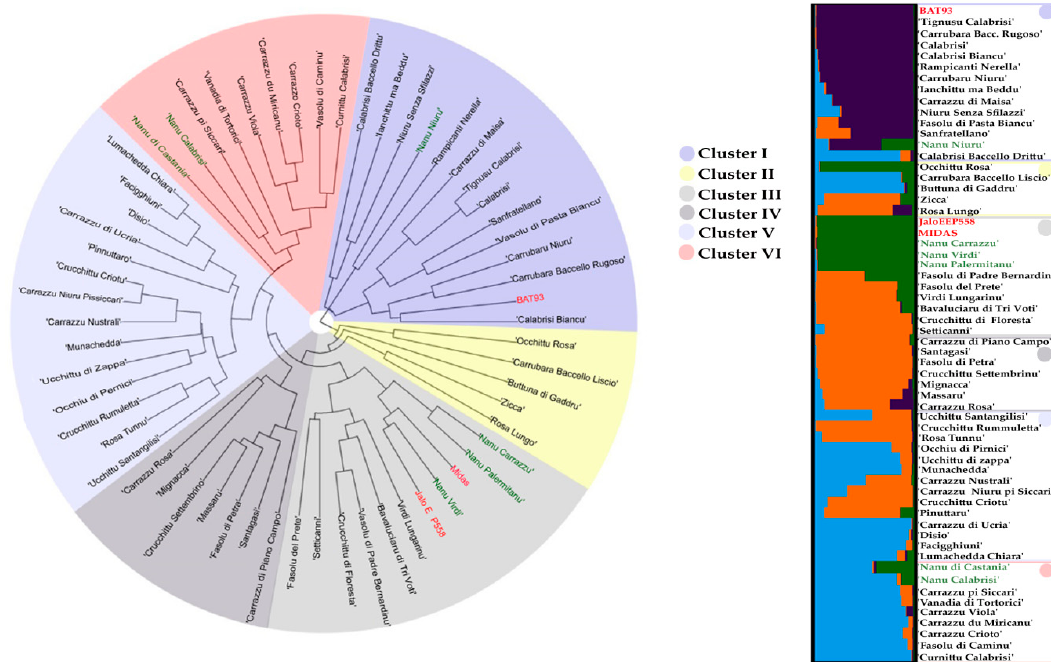
Figure 6. On the left phylogenetic analysis of Sicilian common bean germplasm collection, based on Bruvo’S distance coefficient and UPGMA cluster analysis. JaloEEP558, Midas (Andean) and BAT93 (Mesoamerican) were added as references. On the right Structure inferred for common bean germplasm collection analyzed. A horizontal line represents each sample. The length of colored segment highlights the membership percentage of samples to each group.